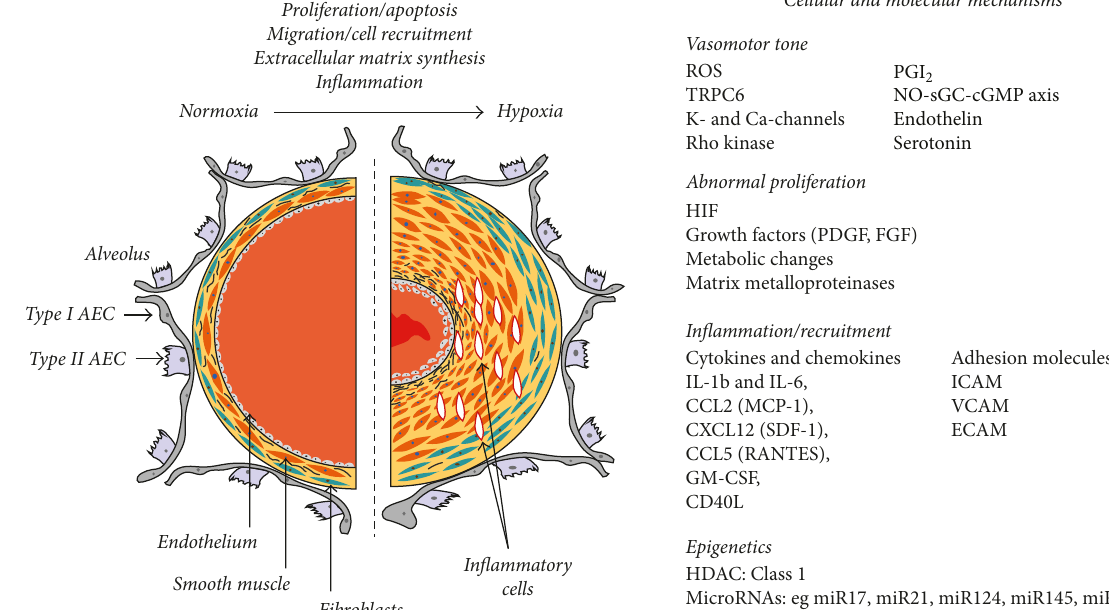
Figure 1: Mechanisms of vascular remodeling in chronic hypoxia (from [16], permission granted). AEC: alveolar epithelial cell; CCL: C-C motif chemokine ligand; CD40L: CD40 ligand; CXCL: C-X-C motif chemokine ligand; ECAM: endothelial cell adhesion molecule; FGF: fibroblast growth factor; HDAC: histone deacetylase; GM-CSF: granulocyte macrophage colony stimulating factor; HIF: hypoxia-inducible factor; ICAM: intercellular adhesion molecule; IL: interleukin; NO-sGC-cGMP: nitric oxide-soluble guanylate cyclase-cyclic GMP; MCP: monocyte chemoattractant protein; PDGF: platelet-derived growth factor; PGI 2 : prostacyclin; RANTES: regulated upon activation, normally T-expressed, and presumably secreted; ROS: reactive oxygen species; SDF: stromal cell-derived factor; TRPC6: transient receptor potential cation channel 6; VCAM: vascular cell adhesion